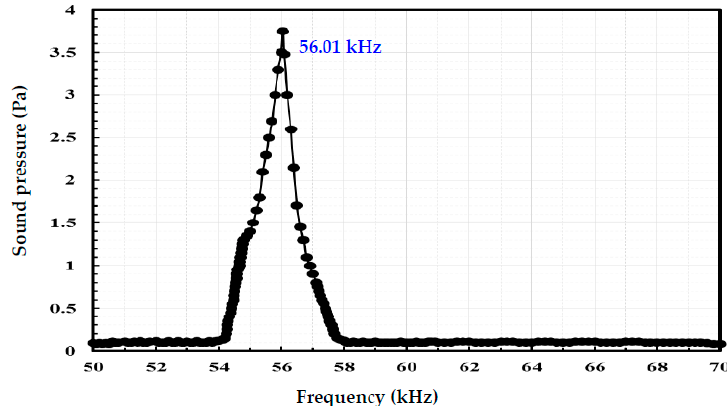
Figure 8. Frequency dependence of output sound pressure of a device in the acoustic array at bias of 300 mV.